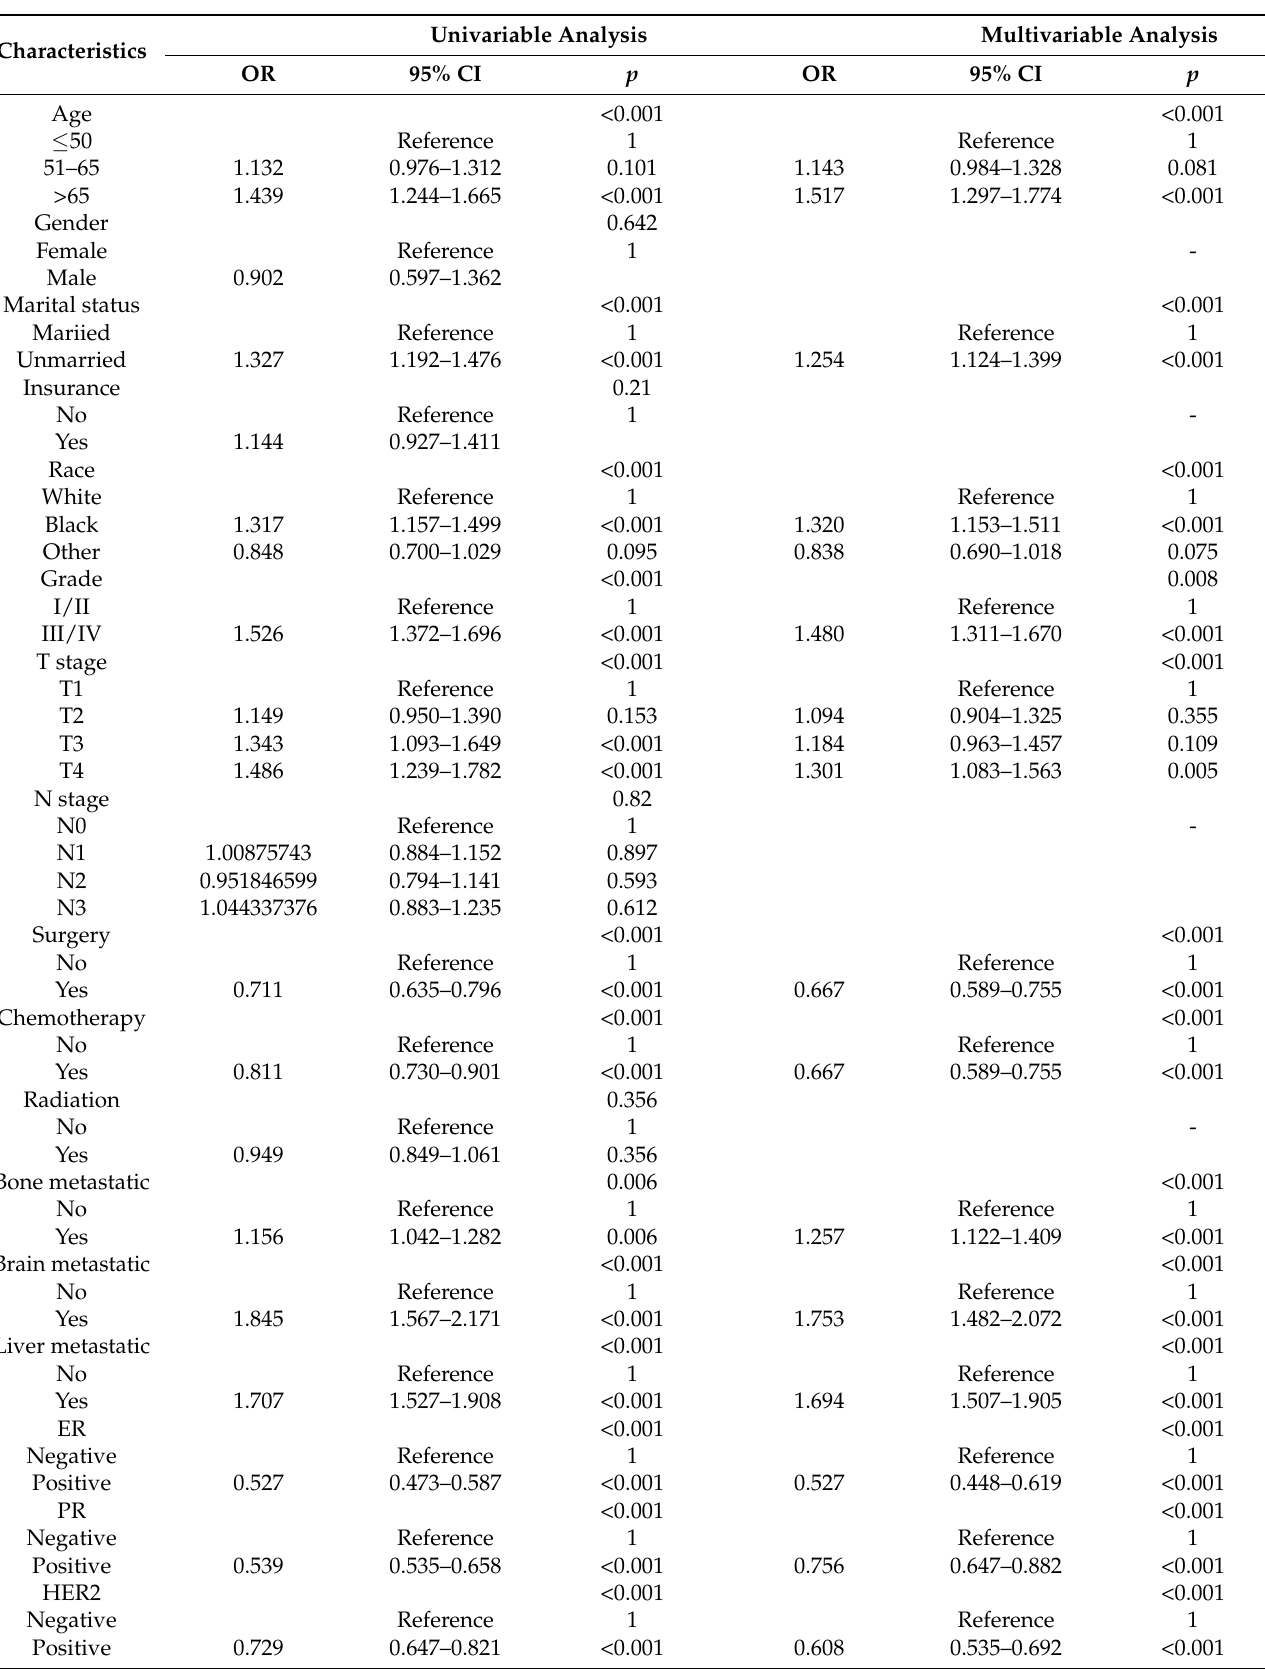
Table 2. Univariable and multivariable Cox regression model analyses of OS for